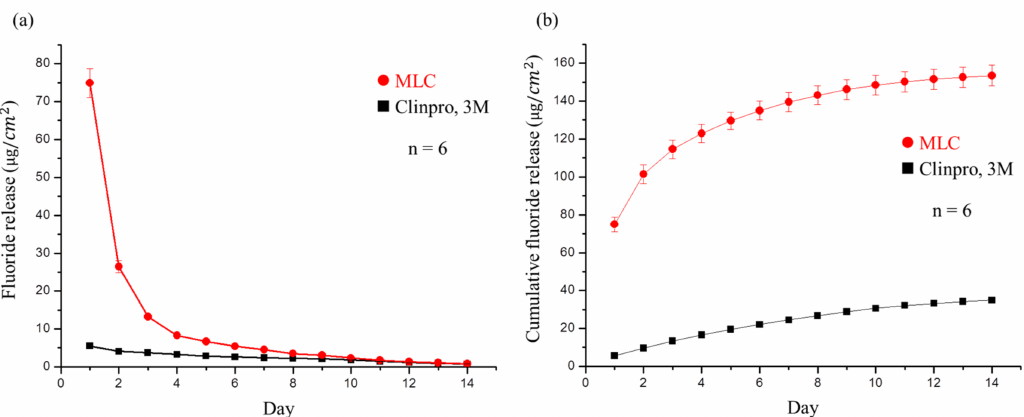
Figure 6. ( a ) Fluoride release per square centimeter of Clinpro TM and MLC each day for 14 days. No significant di ff erence was observed on day 14. ( b ) Cumulative fluoride release of Clinpro TM and MLC each day for 14 days. Significant di ff erences existed between both materials at all times during the trial.